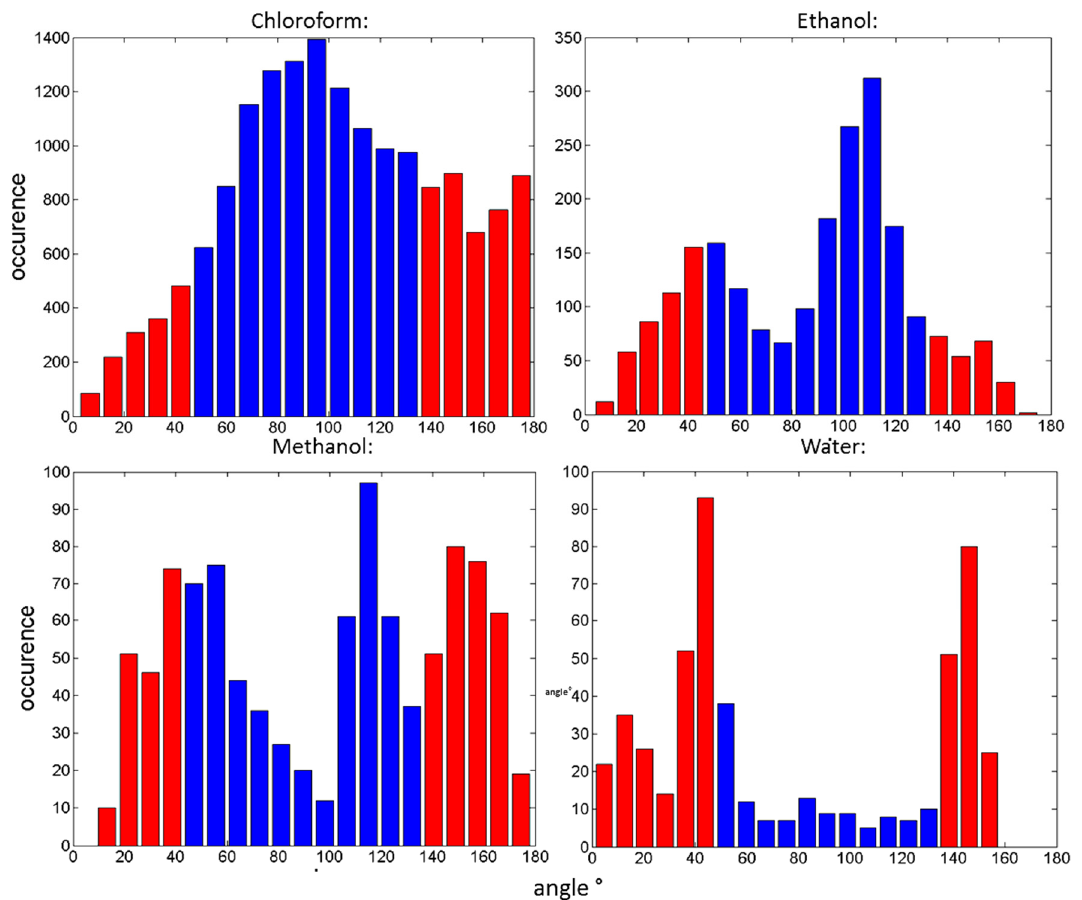
Figure 3. Histograms of paracetamol molecules simulated in different solvents. The peaks indicate the positions of paracetamol molecules while forming hydrogen bond, peaks in the middle indicate the orthogonal position of the molecules, while peaks at the ends imply at parallel orientation. Table 5. Results of paracetamol simulations in different solvents.